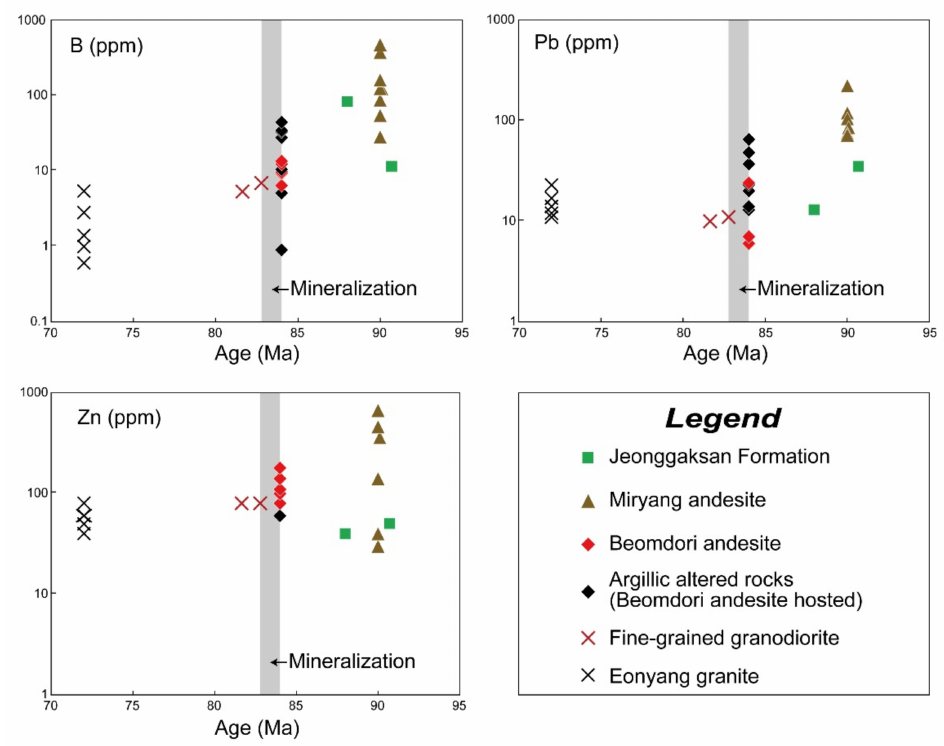
Figure 23. Age vs. B, Pb, and Zn diagrams for the altered rocks and neighboring granitoids of the Gukjeon Pb–Zn